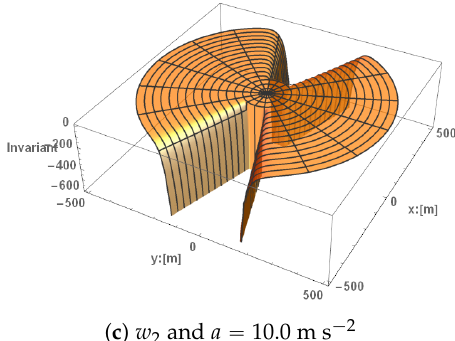
Figure A6. The acceleration, a , of the invariant w 2 is plotted in the figures above. The other parameters were set to be σ “ 50,000 m ´ 1 , ρ “ 100 m, and t “ 1 s. The plots were rendered using Mathematica’s ® RevolutionPlot3D. It plots a function by rotating the function around the z-axis. The amount that the space diverges from being flat is represented by the invariant function’s magnitude, and its amount is labeled on the vertical axis. The x and y-axis are displayed on the plots, and they display the distance from a spaceship in the flat portion at the center of each figure. Each radial line in the plot corresponds to a distance of approximately 33 m. The constant portion to the right of the harbor is to the front of the warp bubble, and the constant portion to the left of the harbor is the back of the warp